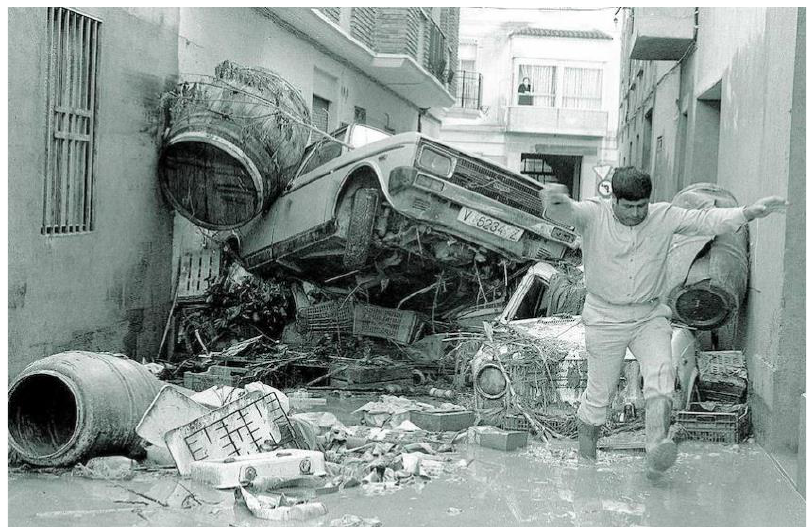
Figure 3. The flood called “Pantaná de Tous” (Júcar River), October 1982 . Source: Diario Las Provincias [50].